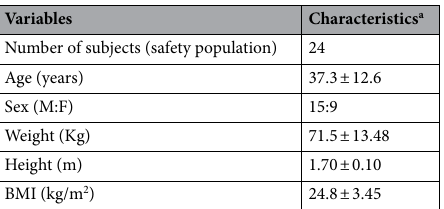
Table 2. Demographic characteristics of participants. M Male; F Female; BMI body mass index. a Data are mean ±